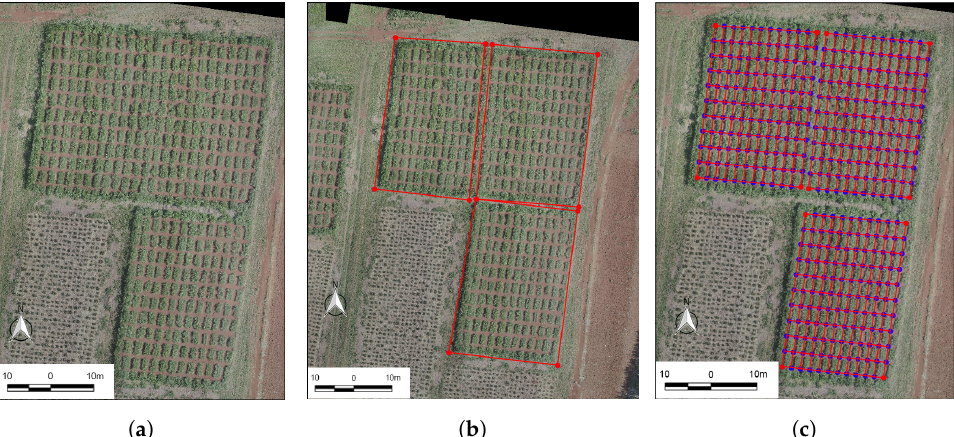
Figure 2. Plots identification procedure: ( a ) Orthomosaic; ( b ) user defined experiment field in red and; ( c ) plots defined using our Python